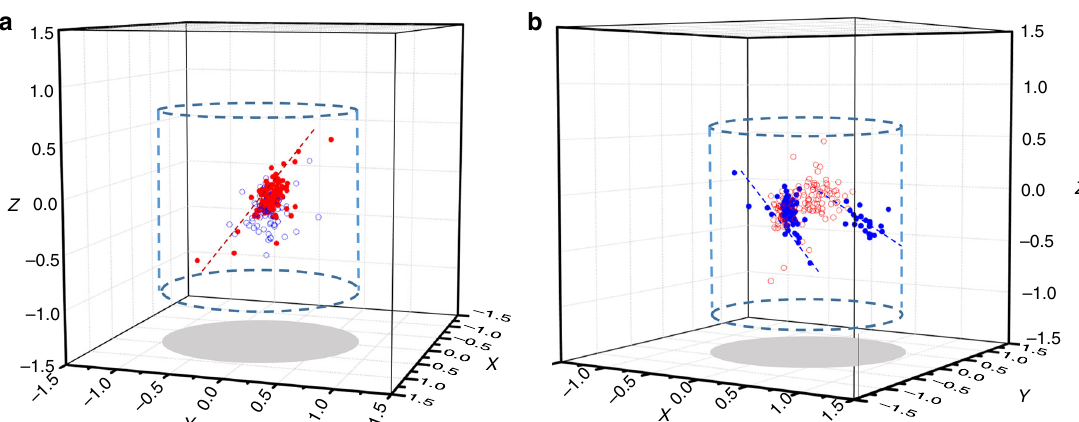
Fig. 4 Projections of AE locations in D1996 showing near planar distributions. Blue dashed cylinders outline the sample after the experiment. a Group 1 events (red solid circles) form a planar distribution as indicated by the red dashed line (see Supplementary Movie 1 for history of event development). Group 2 events are shown as open blue circles in this projection. b Group 2 events (blue solid circles) form 2 planar distributions indicated by the blue dashed lines (see Supplementary Movie 2 for history of event development). Group 1 events are shown as open red circles in this projection. Scales shown in mm